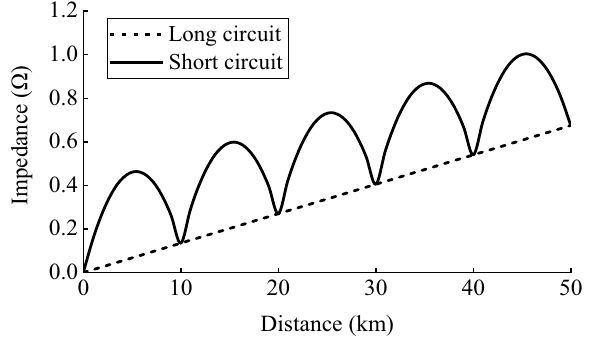
Fig. 13 Equivalent impedance of traction network